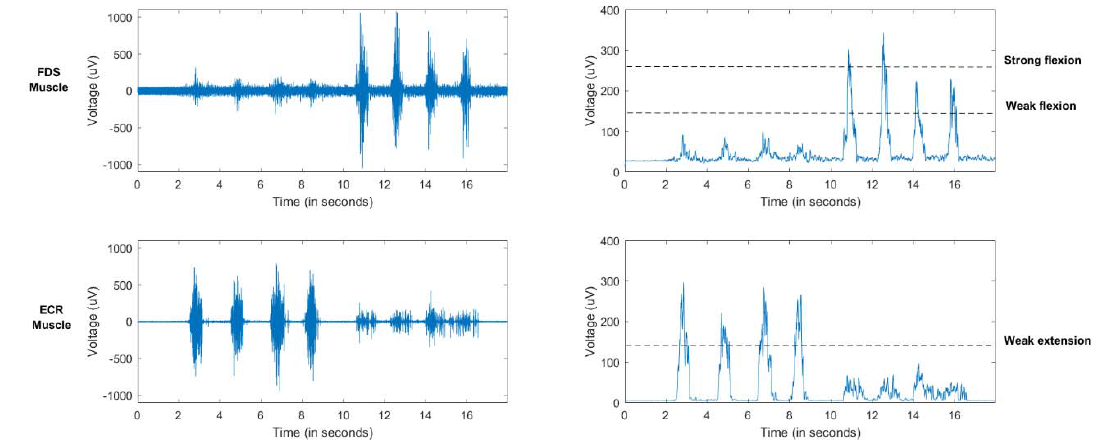
Figure 3. EMG raw signal for several flexion/extension wrist movements ( left ). Processed EMG signal and estimative thresholds ( right ).